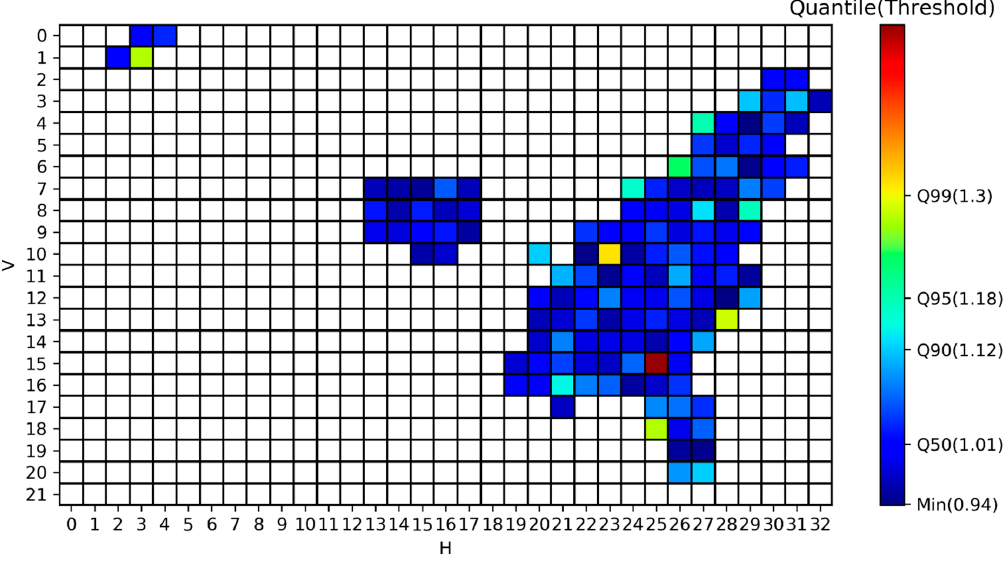
Figure 5. Illustration of outlier detection results after the reproduction. The color bar shows LOS value at the 50%, 90%, 95%, and 99% cut points. X and y axes show horizontal (H) and vertical (V) tile number,